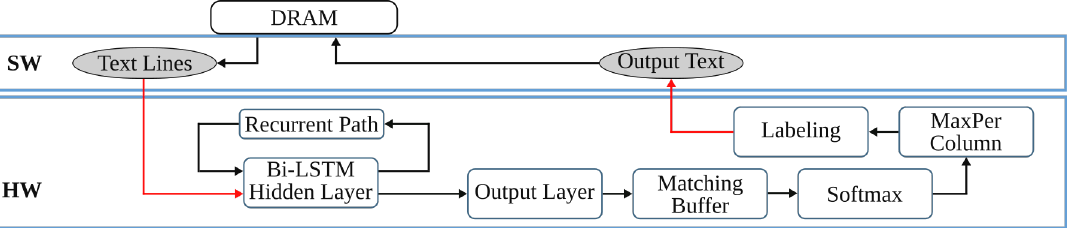
Figure 7. The system-level architecture of the i DocChip text line recognition step.